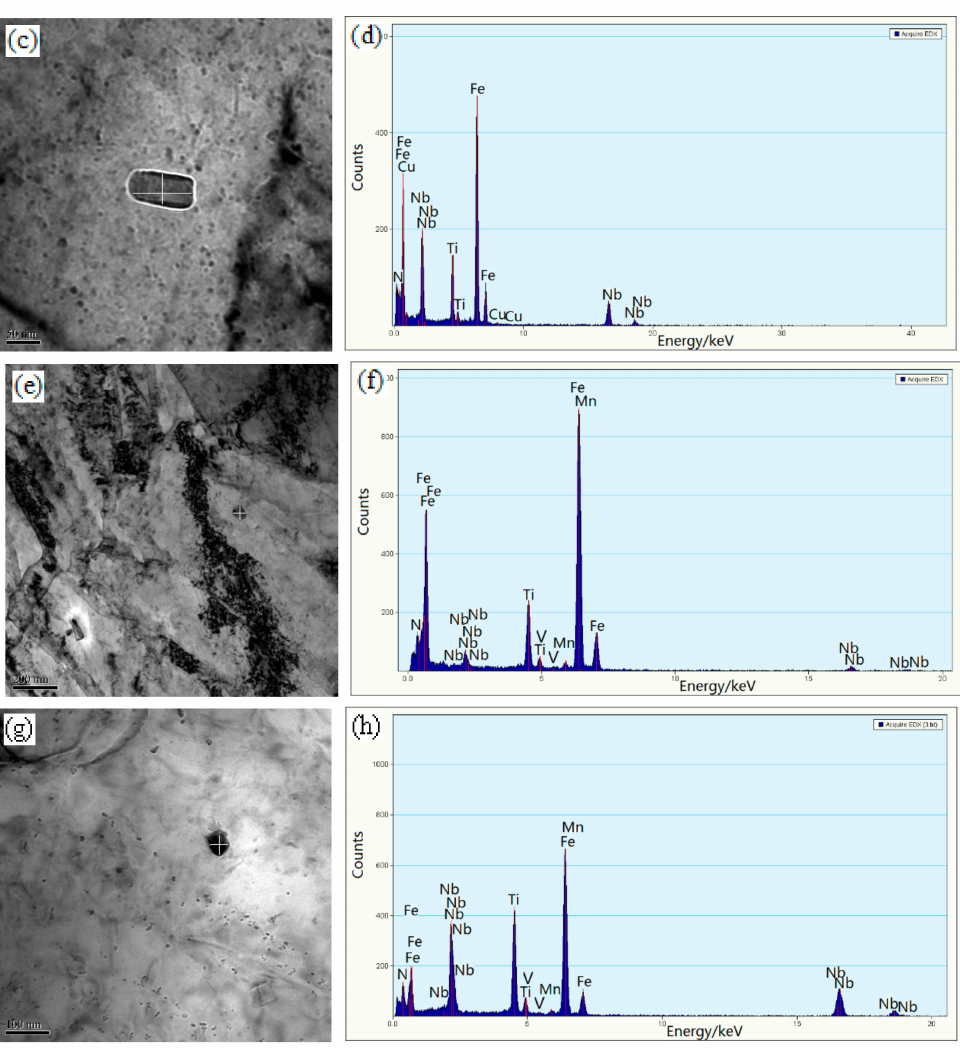
Figure 10. The precipitate particle and its EDS image held at ( a , b ) 550 ◦ C; ( c , d ) 600 ◦ C; ( e , f ) 700 ◦ C; ( g , h ) 800 ◦